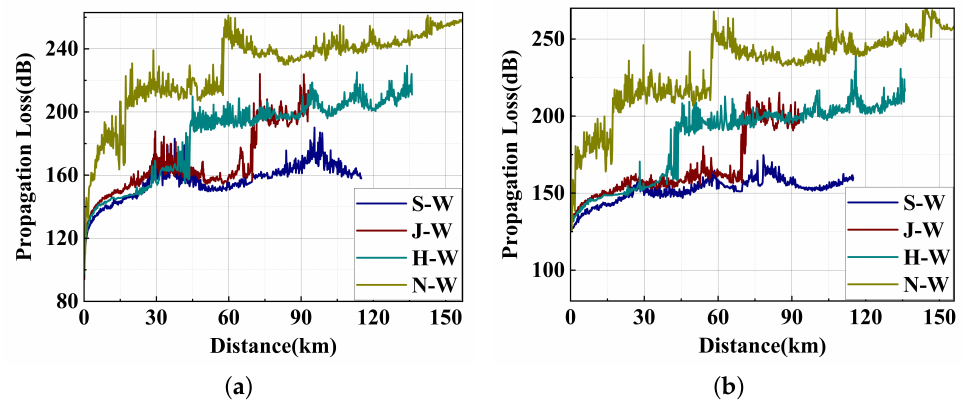
Figure 27. The range-dependent PL on four intercity links at antenna heights of ( a ) 60 m and ( b ) 40 m. ( a ) Range-dependent PL from four cities to Wuxi at ANH = 60 m. ( b ) Range-dependent PL from four cities to Wuxi at ANH = 40